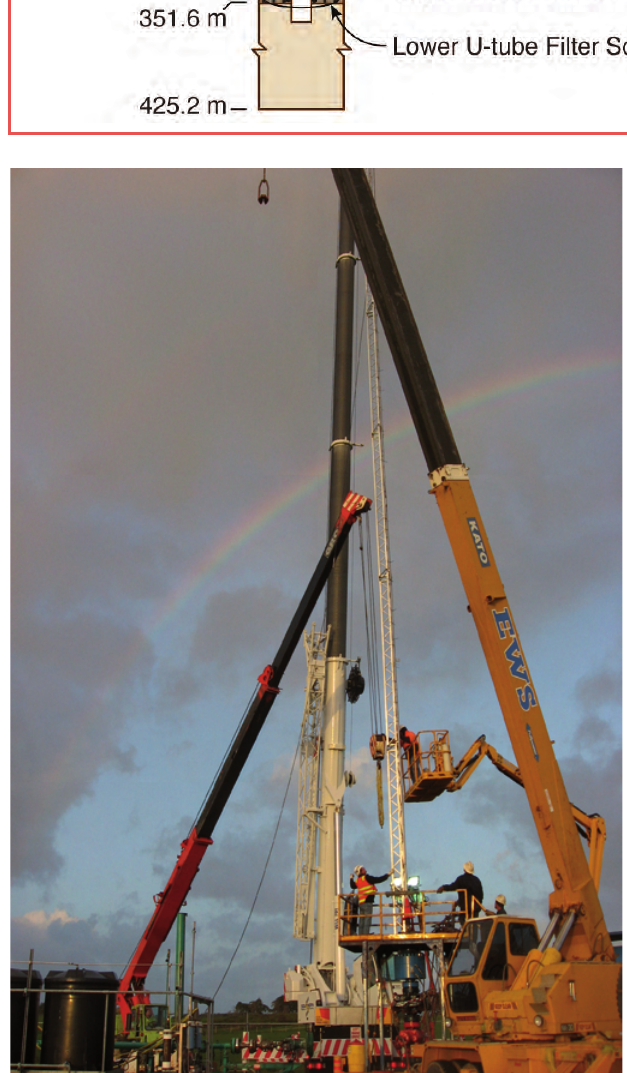
Figure 4. [A] Borehole NC-EWDP-24PB completion schematic showing permanently installed U-tube samplers using alternating levels of sand and ben/sand backfill. [B] Running-in-hole with U-tubes and DTPS sensor being strapped onto a central 2 " stainless steel